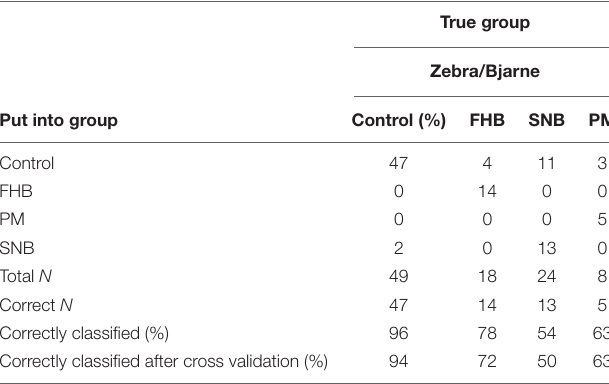
TABLE 10 | Summary of classification of fungal diseases on wheat (when data sets from ‘Bjarne’ and ‘Zebra’ 7, 14, and 21 days after inoculation were combined).